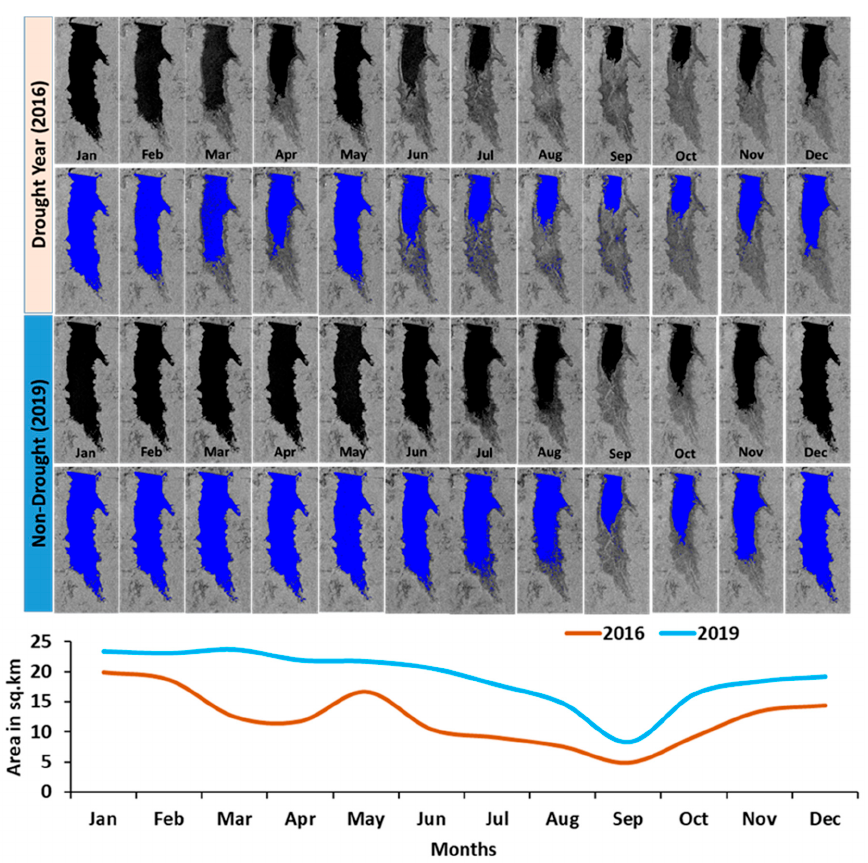
Figure 6. Water surface area changes through drought years and non-drought years (Tank A), with dark black for observed water in SAR image and blue color for extracted water. The water surface area of Tank A continued to be less than 30% of the maximum area from July to October 2016, with the lowest area of 20% being recorded in September. The specialty is that in 2019, the minimum water surface area was only 37%, and it was re- ported only in one month. In 2019 the surface water area was more than 80% for 7 months, and in 2016, only one month exceeded 80%; since January 2016, the surface water area has been gradually declining. Table 4 shows the numerical values of the monthly water sur- face area of Tank A and Tank D. Since the temporal resolution of S1 data in Sri Lanka range from 7 to 13 days, it is possible to calculate the surface water area using about 3–6 satellite images per month. The greatest advantage of using SAR (Sentinel-1) satellite data is that they provide more accurate values of water surface area consistently under any environmental conditions. However, long-term water area data can be easily calculated by combining Landsat data and Sentinel-1 data via GEE, making the SWSI index calculation even more efficient.